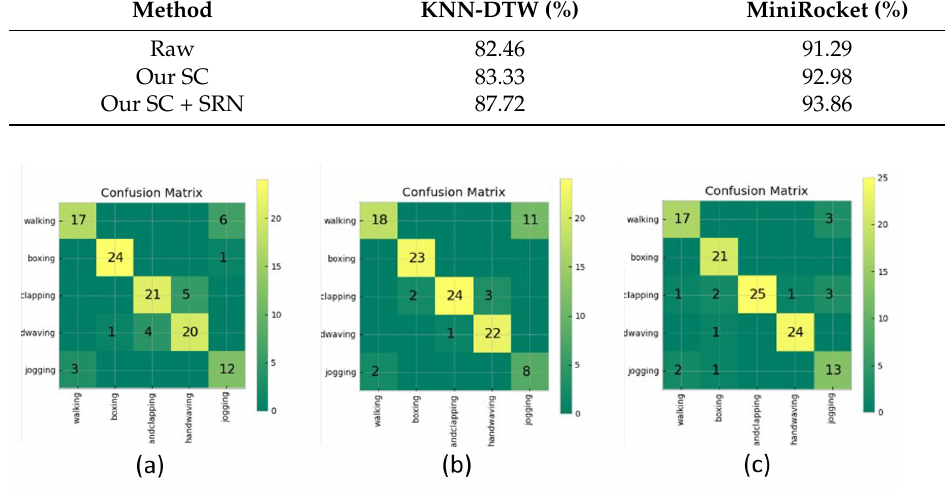
Figure 3. Covariance matrix for classification with KTH-5 using different methods of processing